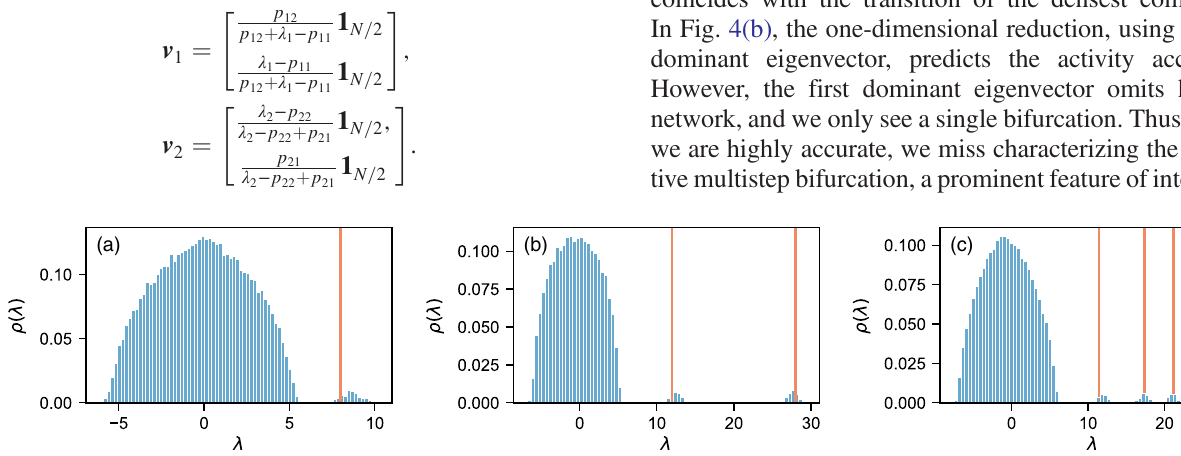
FIG. 5. Spectral density ρ ð λ Þ for (a) random networks of 80 nodes with connection probability p ¼ 0 . 1 , (b) the SBM with two communities of 40 nodes with in-connection probabilities p 11 ¼ 0 . 3 and p 22 ¼ 0 . 7 and out-connection probabilities p 12 ¼ p 21 ¼ 0 . 01 , and (c) the SBM with four communities of 40 nodes with in-connection probabilities p 11 ¼ 0 . 4 , p 22 ¼ 0 . 6 , p 33 ¼ 0 . 7 , and p 44 ¼ 0 . 9 and out-connection probability p rs ¼ 0 . 05 ∀ r ≠ s . The orange lines highlight the position of the dominant and subdominant eigenvalues in the expected network. Each spectral density is produced by collecting spectra from 500 network